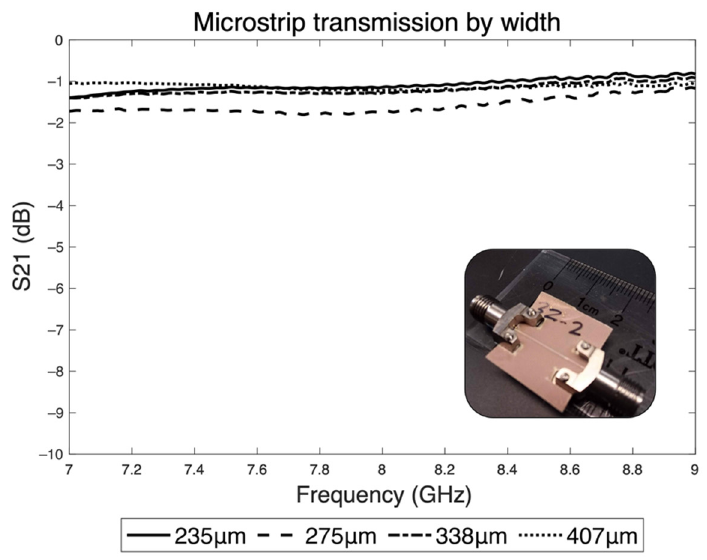
Figure 3. S21 transmission values for a range of microstrip widths across the 8 GHz frequency of interest show no significant change as microstrip width increases. This data suggests that the trend towards a more negative S11 with increasing microstrip width, Figure 2b, is not caused solely by the microstrip variability.